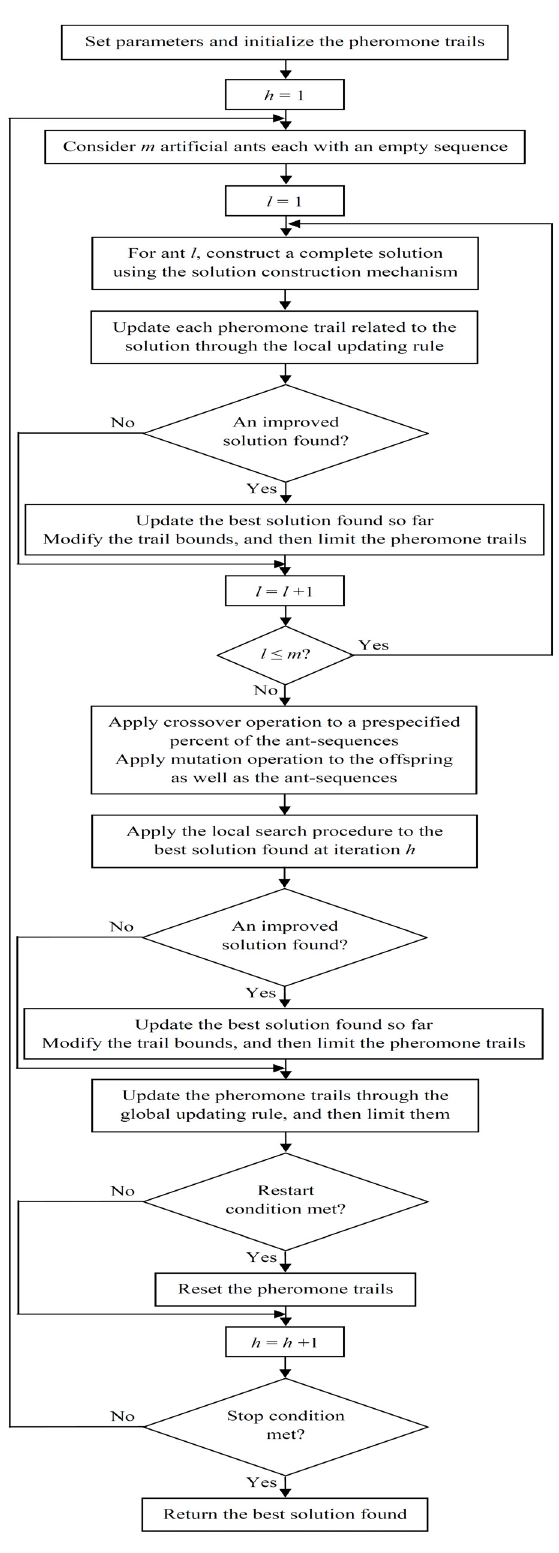
Fig. 1. Flow chart of the proposed ACO